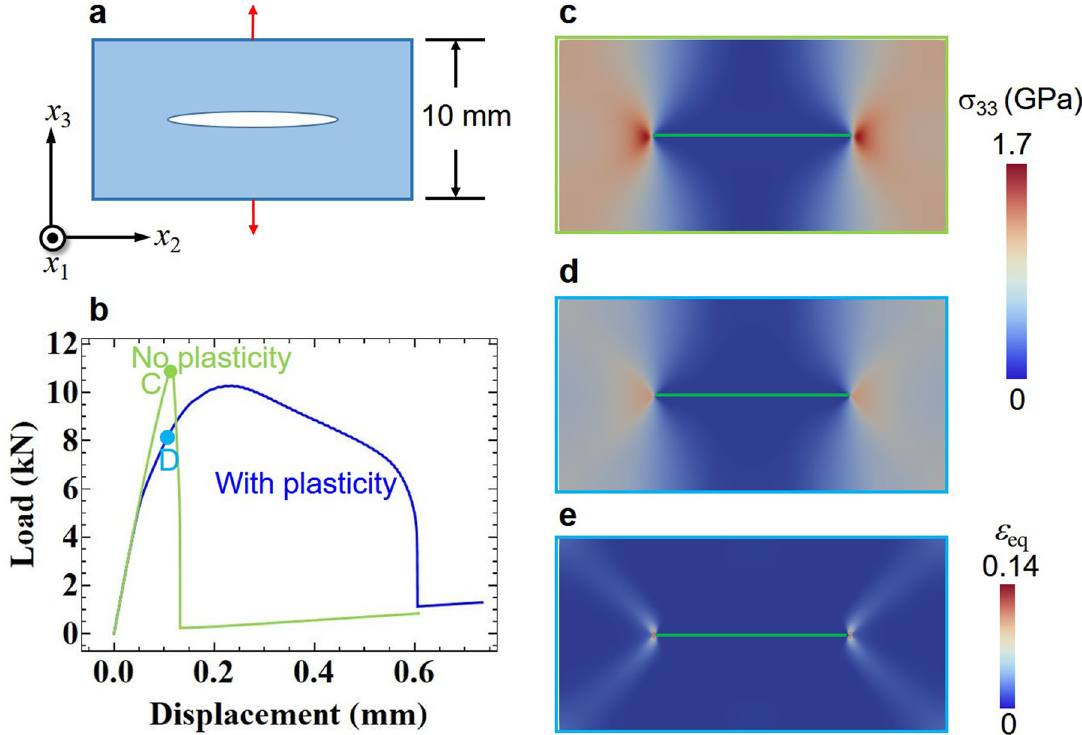
Fig. 5 Crack growth under monotonic displacement-controlled tests. a Schematic for system setup. b Load-displacement curves with and without plasticity. c , d Stress component along the loading direction with and without plasticity corresponding to Points C and D in ( b ), respectively. e Distribution of equivalent plastic strain corresponding to ( d